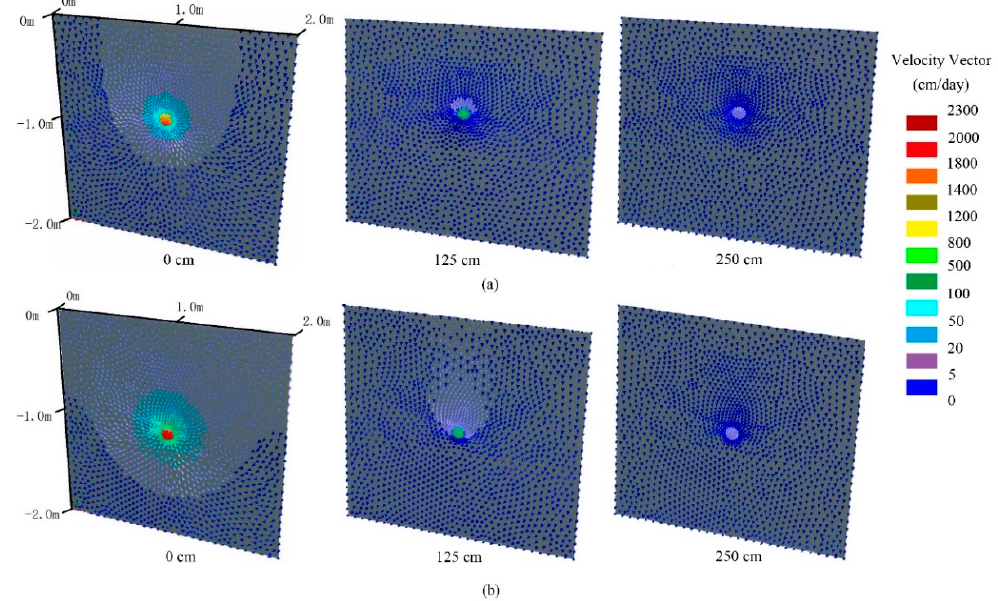
Figure 5. Simulated velocity vectors in di ff erent soil vertical profiles (0, 125, and 250 cm away from outlet) for treatment D1W1 ( a ) and D2W1 ( b ) at the second leaching event (16th day). The color legend on the right side indicated the water velocity vector in soil profile, and di ff erent color lump represents a certain range of velocity vector (e.g., the darker blue lump at the bottom of the color legend means the velocity vector is in the range of 0–5 cm day − 1 ).